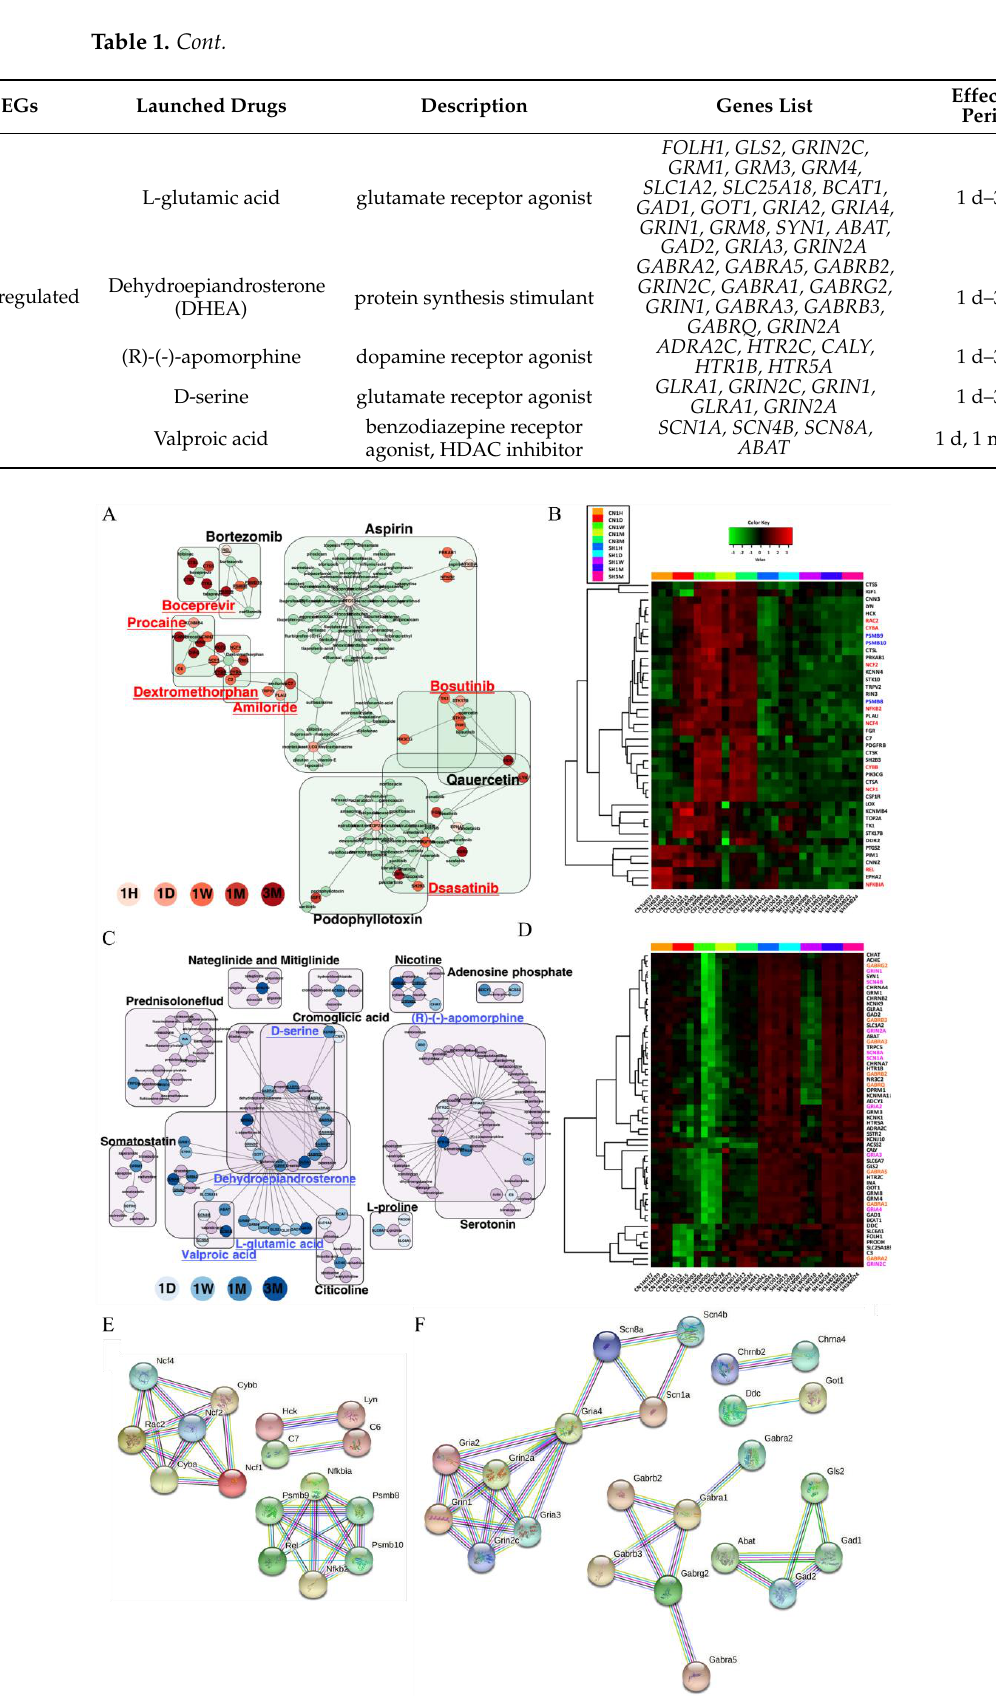
Figure 8. Gene – drug interaction network and PPI network. Gene – drug interaction networks in- Figure 8. Gene–drug interaction network and PPI network. Gene–drug interaction networks volved in up- ( A , B ) and downregulation ( C , D ) and their expression patterns are shown. Up- and downregulated DEGs across the five time points are connected with the potential therapeutic drugs with specific color indications (aqua green for up and light purple for down). The up- and down- regulated DEGs for each period were classified according to the red and blue gradient scales. In the expression heatmap, highly enriched genes for drug targets in the network group were color-coded. The PPI networks of all genes involved in up- and downregulated gene – drug interaction networks were investigated using the STRING online database ( E , F ). The detailed interactions clustered to- gether with the gene of the drug target are listed in Supplemental Table S7.